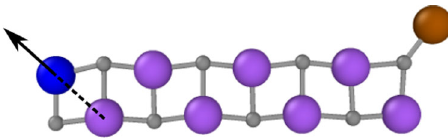
Fig. 6 Optimized structure of the Na 9 Cl þ cluster. Sodium atoms are 8 shown in purple, blue and brown, chlorine atoms in gray. The arrow indicates the direction along which the blue sodium atom is moved for the energy and force plots in Fig. 7a and 7b. The position of this atom is de fi ned by the Na – Na distance indicated as dashed line.